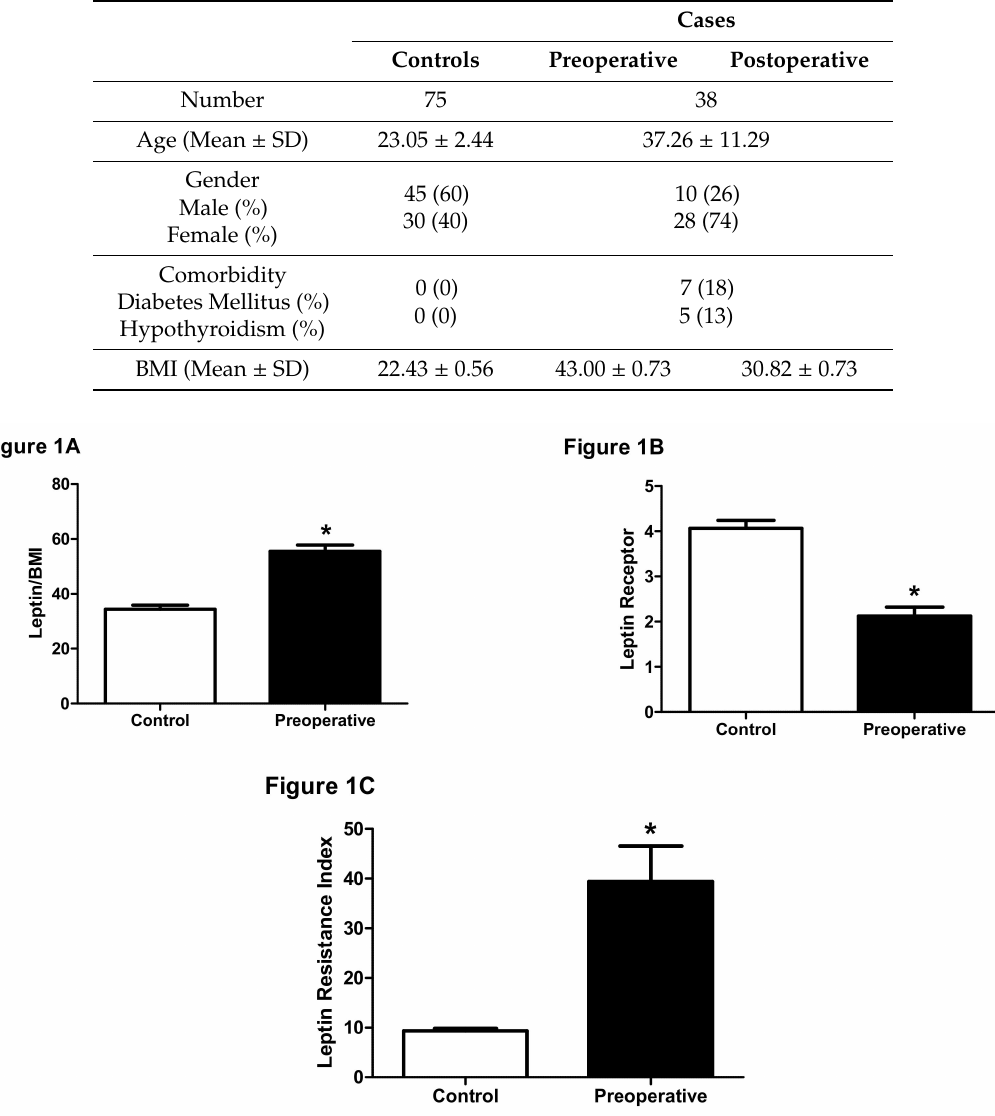
Table 1. Descriptive statistics of major demographic, clinical, and anthropometric characteristics of participants.